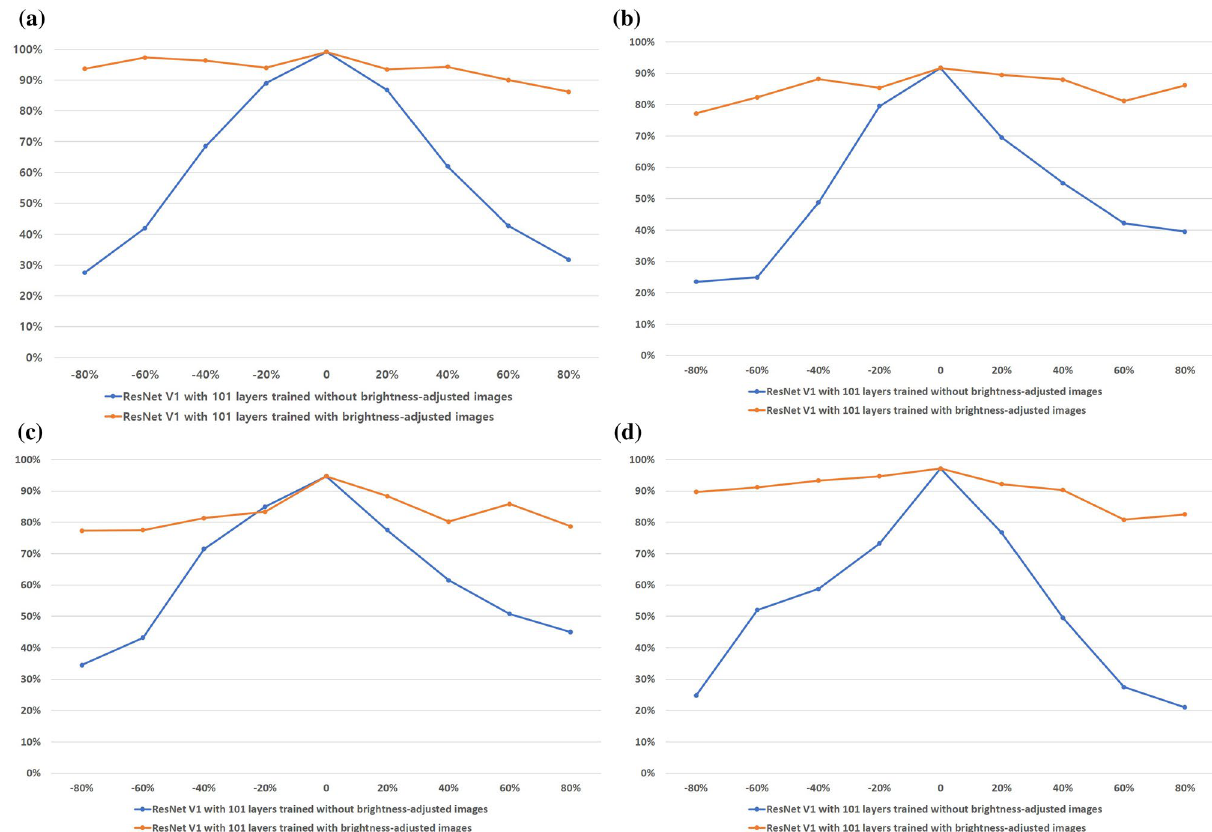
Figure 4. Comparison of ResNet V1 101 trained with and without brightness-adjusted images: ( a ) erythema, ( b ) induration/papulation, ( c ) excoriation and ( d )